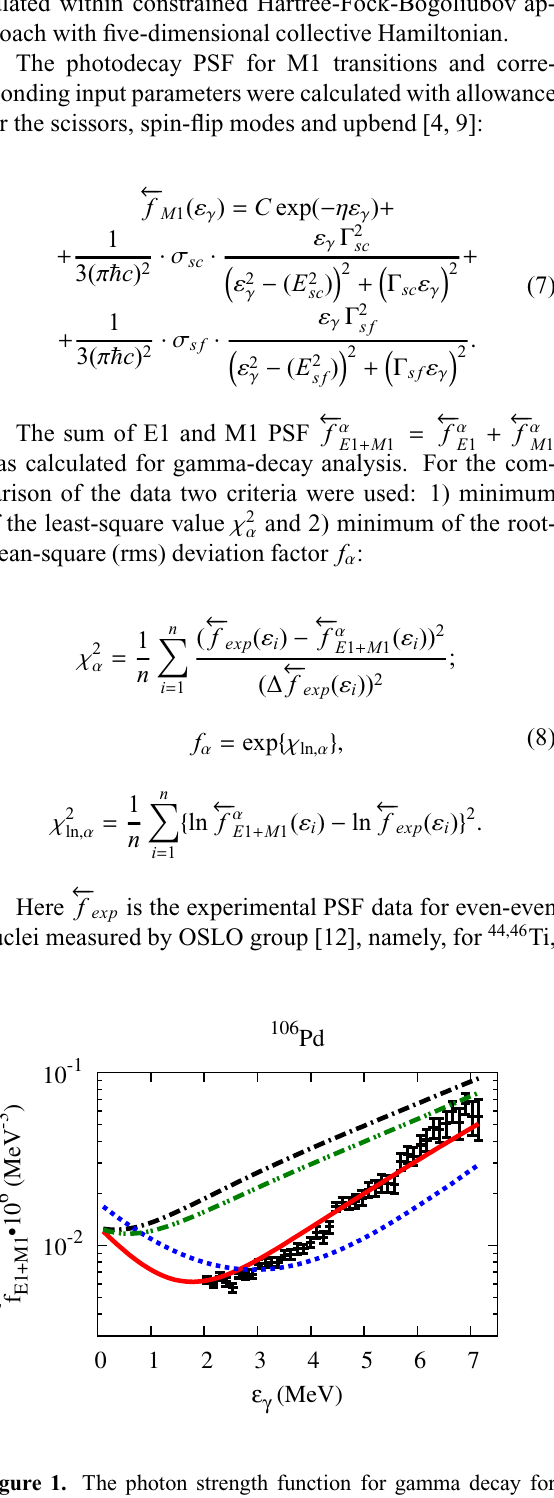
Figure 1. The photon strength function for gamma decay for nuclei 106 Pd in comparison with calculations within di ff erent PSF models: − · − · − SLO (black dash-dotted line), _______ SMLO (solid red line) , · · · · · GLO (blue dotted line), − · · − · · − TLO (green dashed followed by two dots line). Experimental data are taken from ref.[12].